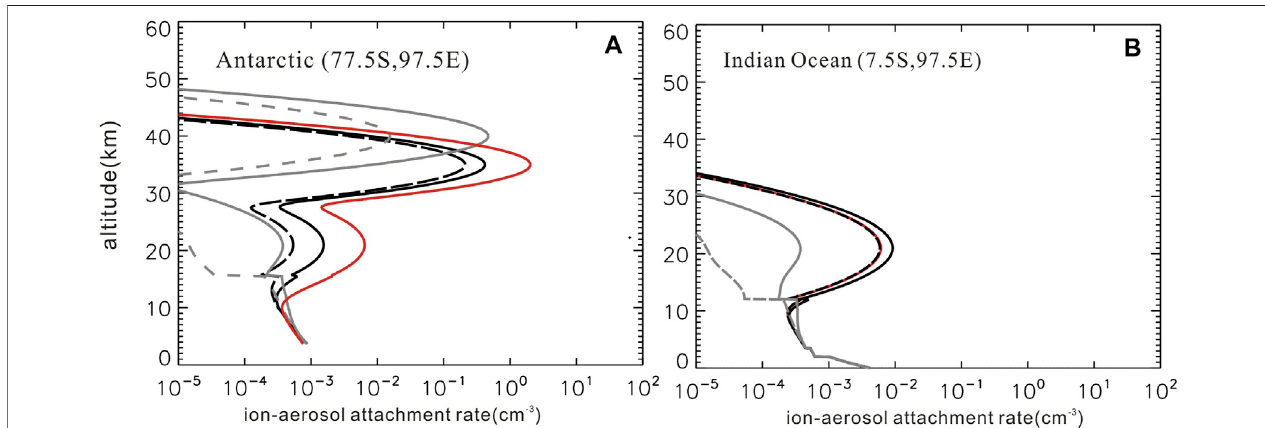
FIGURE 5 | "Vertical pro fi le of the ion-aerosol attachment rate ( β ) in two different regions (Antarctic (A) and Indian Ocean (B) ) under different volcanic eruptions. In thesetwoplots,thegraylinesaretheresultsfromtheTZ06model,thegraysolidlineisthevalueinDJFwithhighvolcanicaerosolloading,andthegraydashedlineisthe valueinDJFwithlowvolcanicaerosolloading.TheblacksolidlineisforDJFin1990 – 1991,theblackdashed lineisforDJFin1991 – 1992,andthered solidlineisforJJA in 1991.